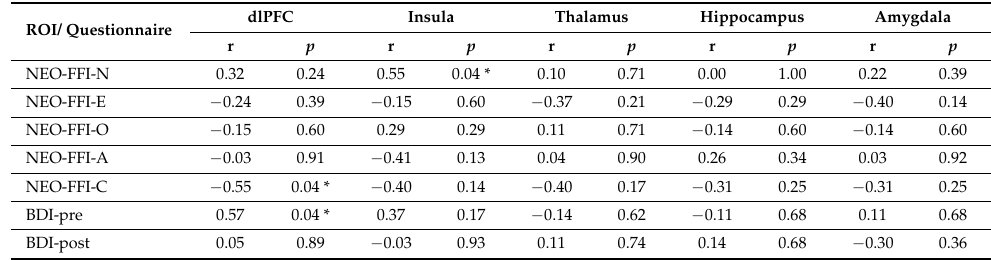
Table 3. MDD REAL correlations between ROIs and